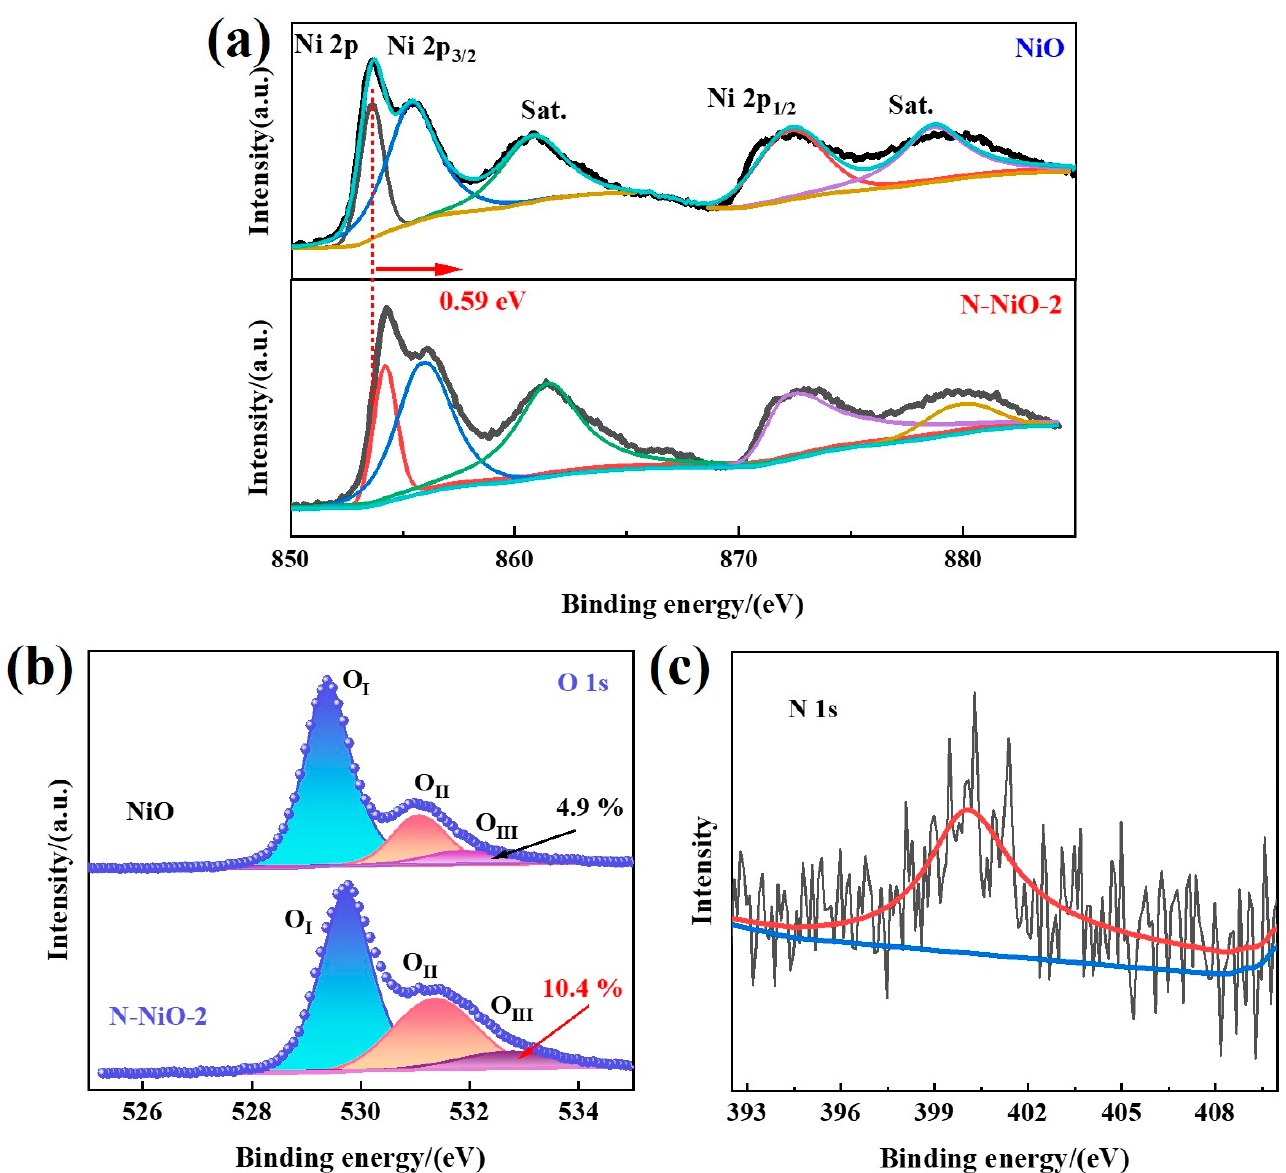
Figure 4. ( a ) X-ray photoelectron spectra of NiO and N-NiO-2: ( a ) Ni 2p, ( b ) O 1s, and ( c ) N 1s. Table 1. The XPS fitted peak area and oxygen-defect ratios on NiO and N-NiO-2.